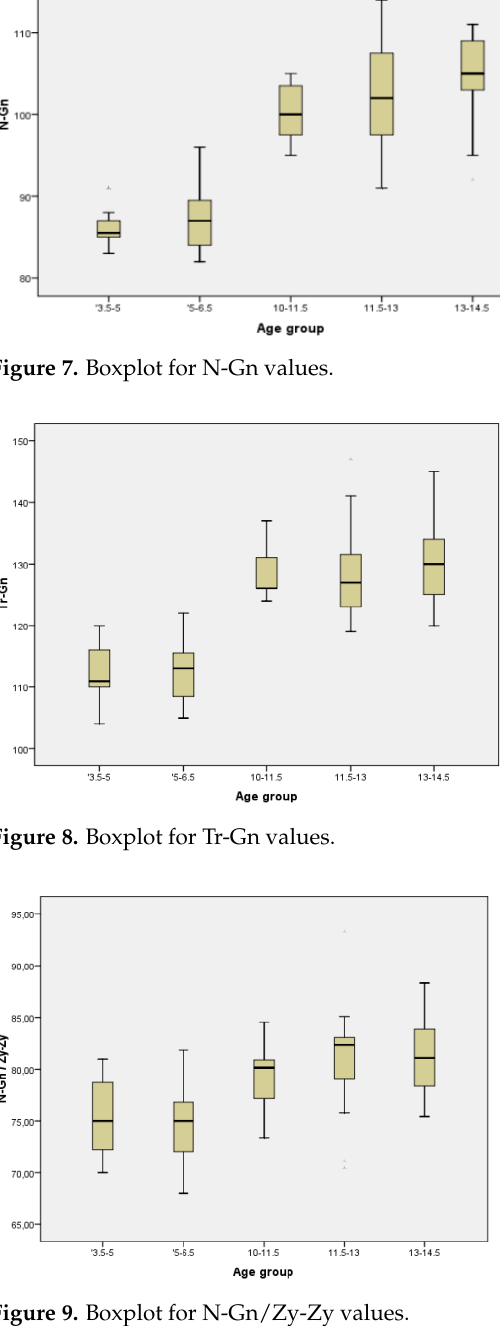
Figure 9. Boxplot for N-Gn/Zy-Zy values.